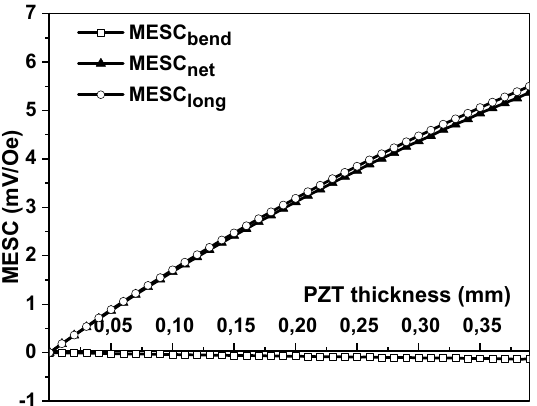
Figure 8. Estimated dependence of MESC in a Ni-PZT-Permendur first-type three-layered struc- ture on the PZT layer thickness. The Ni layer thickness t m 1 = 0.2 mm, the Permendur thickness t m 2 = 0.15 mm. Figures 9 and 10 show the theoretical estimates of the dependencies of the MEVC and MESC for Type 2, Ni-Permendur-PZT, trilayer. As can be seen from Figures 7 and 9, the MEVC for three-layered Ni-PZT-Pe structures has the same value as for the bilayer Ni- PZT structures; thus, using the three-layered Ni-PZT-Pe structures is impractical.